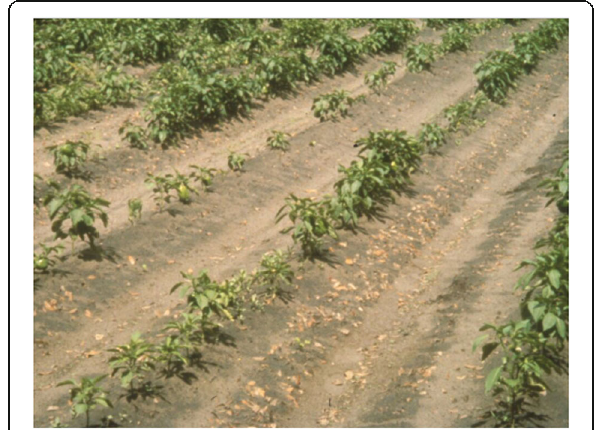
Fig. 2 A pepper field showing patchy areas in the form of stunting and seedling mortality due to root-knot nematode ( Meloidogyne spp.) infestation (Noling